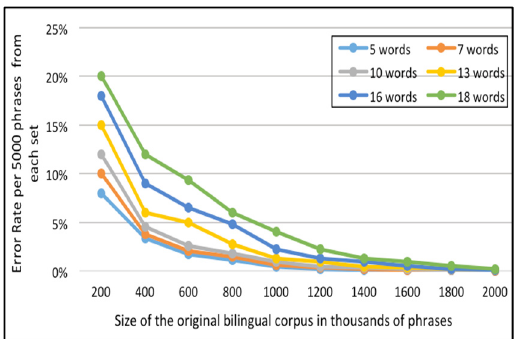
Figure 10. Error rate per 5000 phrases from each set, for the English-Arabic corpora.